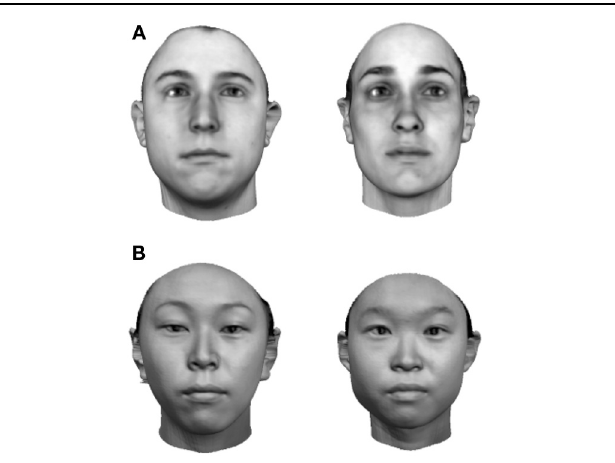
FIGURE 7 | Input face images. (A) German female faces. (B) Japanese female faces.